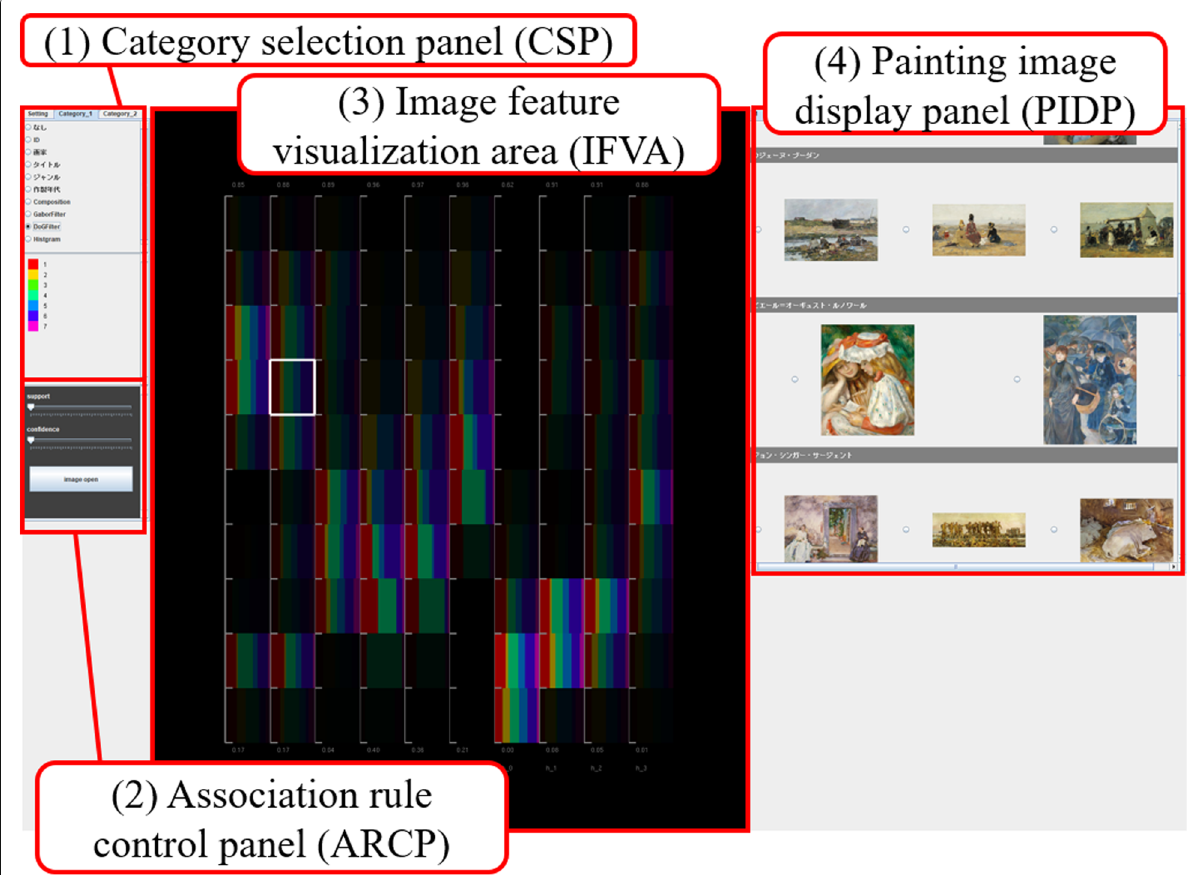
Fig. 2 Snapshot of our application consisting of four user interface components. 1 Category selection panel (CSP). 2 Association rule control panel (ARCP). 3 Image feature visualization area (IFVA). 4 Painting image display panel (PIDP)